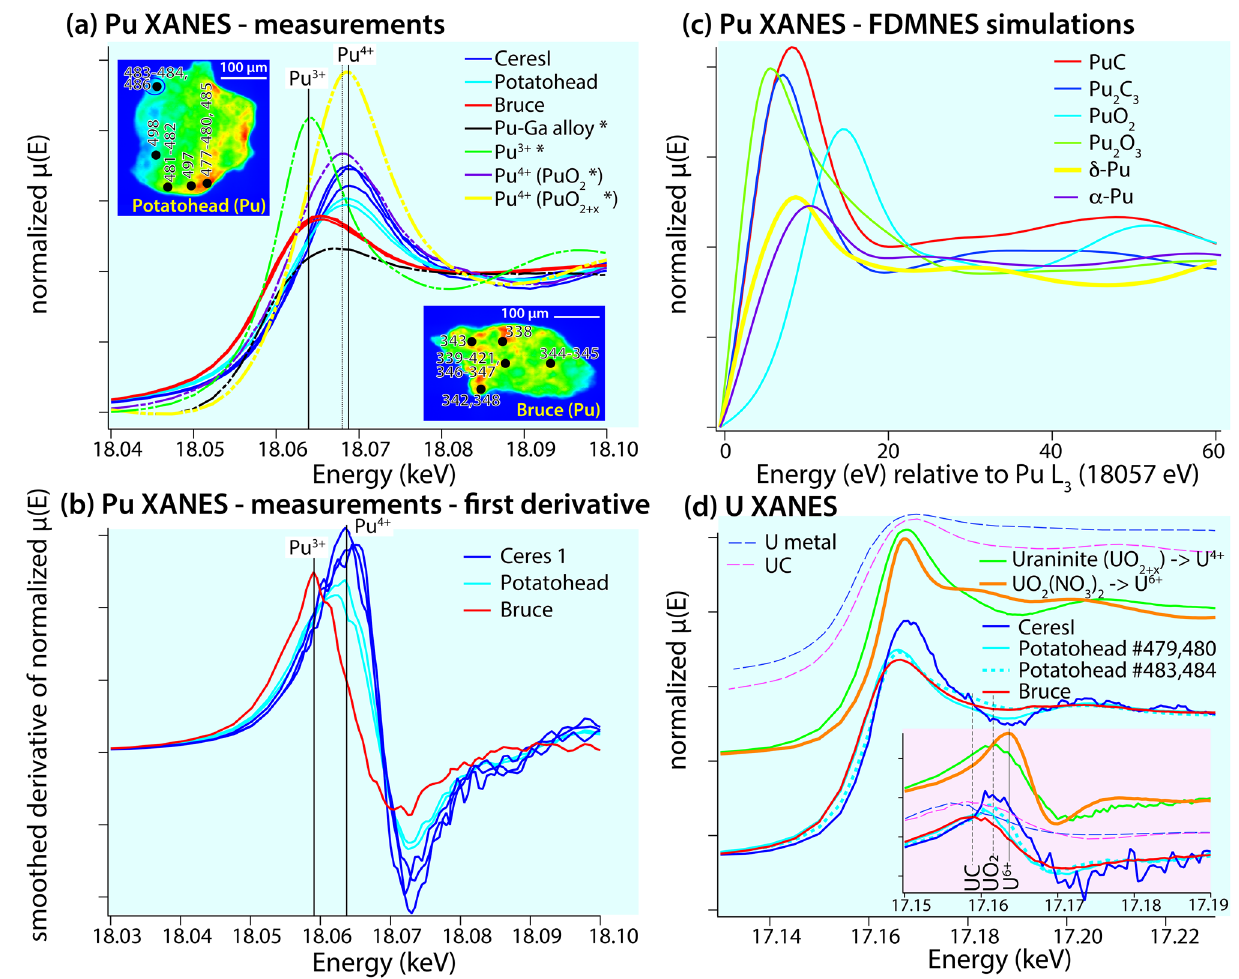
Figure 2. Pu and U µXANES of the Potatohead , Bruce and CeresI hot particles. ( a ) Pu µXANES of particles, compared to Pu XANES standards (*) from Conradson et al. 10,50 ; locations of the spectra are shown in the Pu L 3 µSXRF maps, together with analysis numbers; ( b ) derivatives of the data shown in ( a ); ( c ) first principle FMDNES simulations of Pu spectra. PuO 2 was calculated to check that the simulations can reproduce known spectra and then these simulations were used to calculate Pu-carbide spectra, demonstrating that these have a white line at lower energy than PuO 2 . Crystal structure data: PuC 51 ; Pu 2 C 3 52 ; PuO 2 53 ; Pu 2 O 3 54 ; δ-Pu 55 ; α-Pu 56 . ( d ) U µXANES of particles compared to uraninite (predominantly U 4+ ) and uranyl nitrate (U 6+ ). Inset shows the first derivative of the µXANES spectrum. The spectra of metallic U and UC as taken from 13